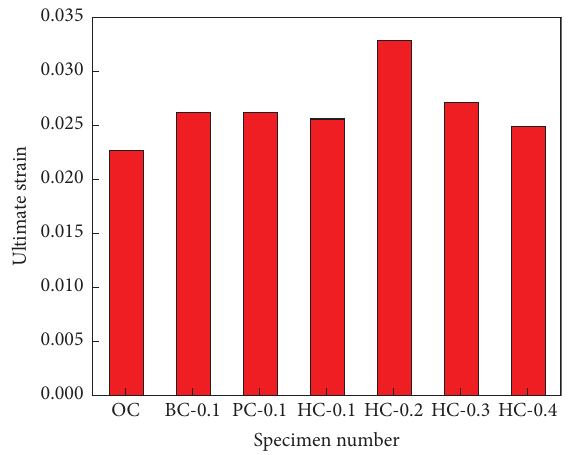
Figure 4: Ultimate